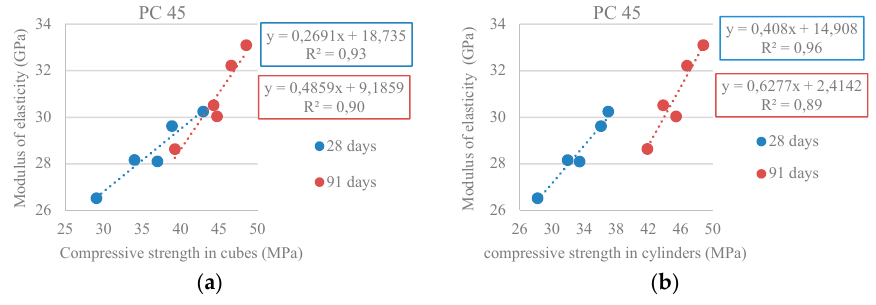
Figure 10. ( a ) Modulus of elasticity vs. compressive strength in cubic specimens at 28 and 91 days (PC 45); ( b ) Modulus of elasticity vs. compressive strength in cylindrical specimens at 28 and 91 days (PC 45).